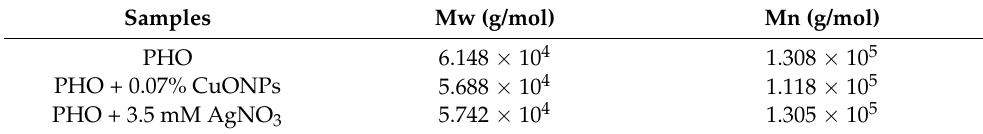
Table 1. Gel permeation chromatography (GPC) of the neat PHO and bioactive films at 35 °C. Samples